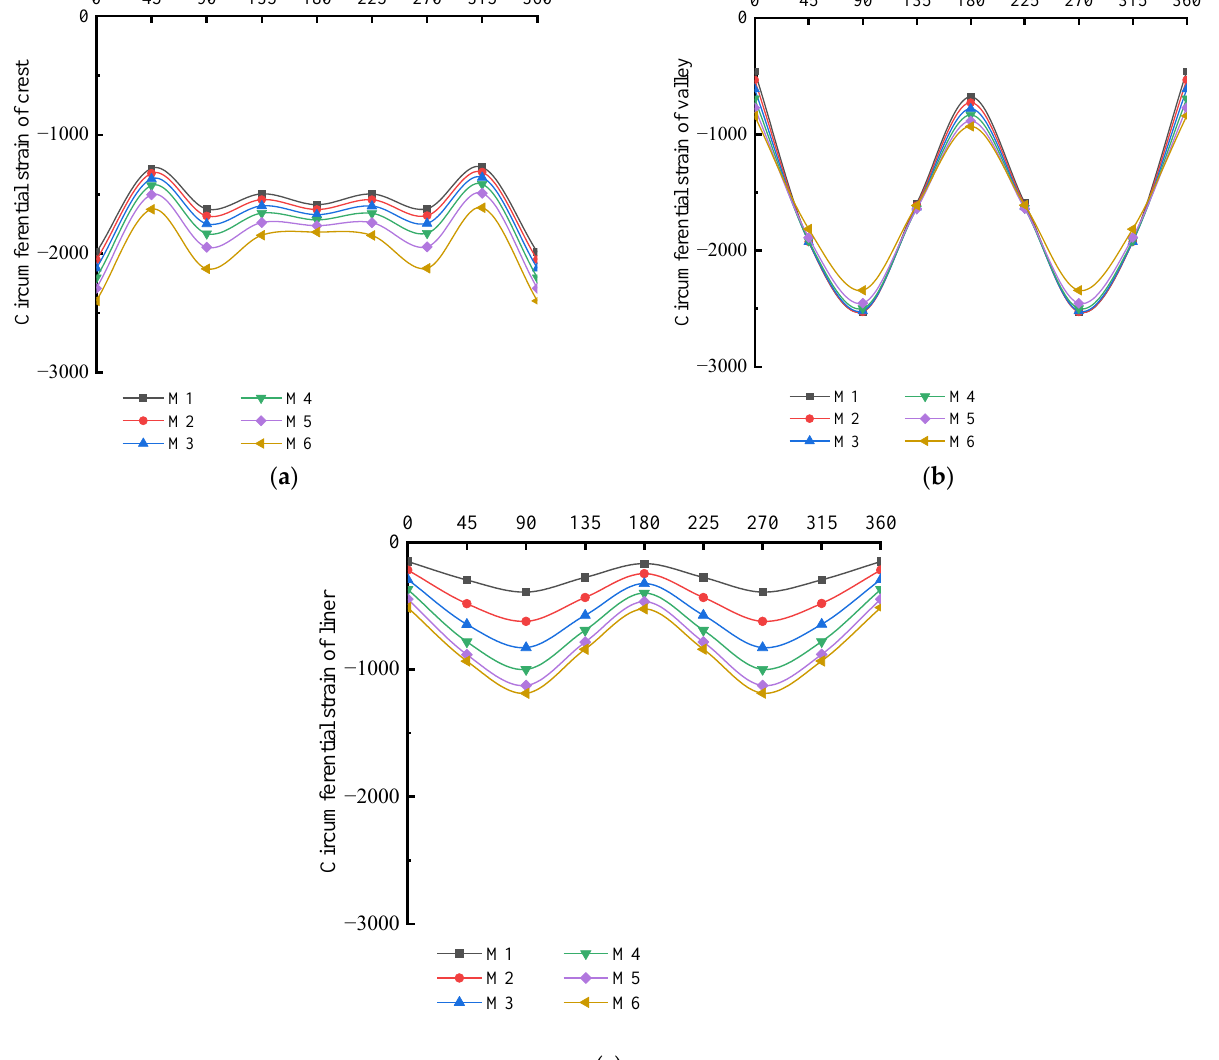
Figure 20. Circumferential strain of various interior and exterior wall thicknesses. ( a ) Crest; ( b ) Valley; ( c ) Liner.